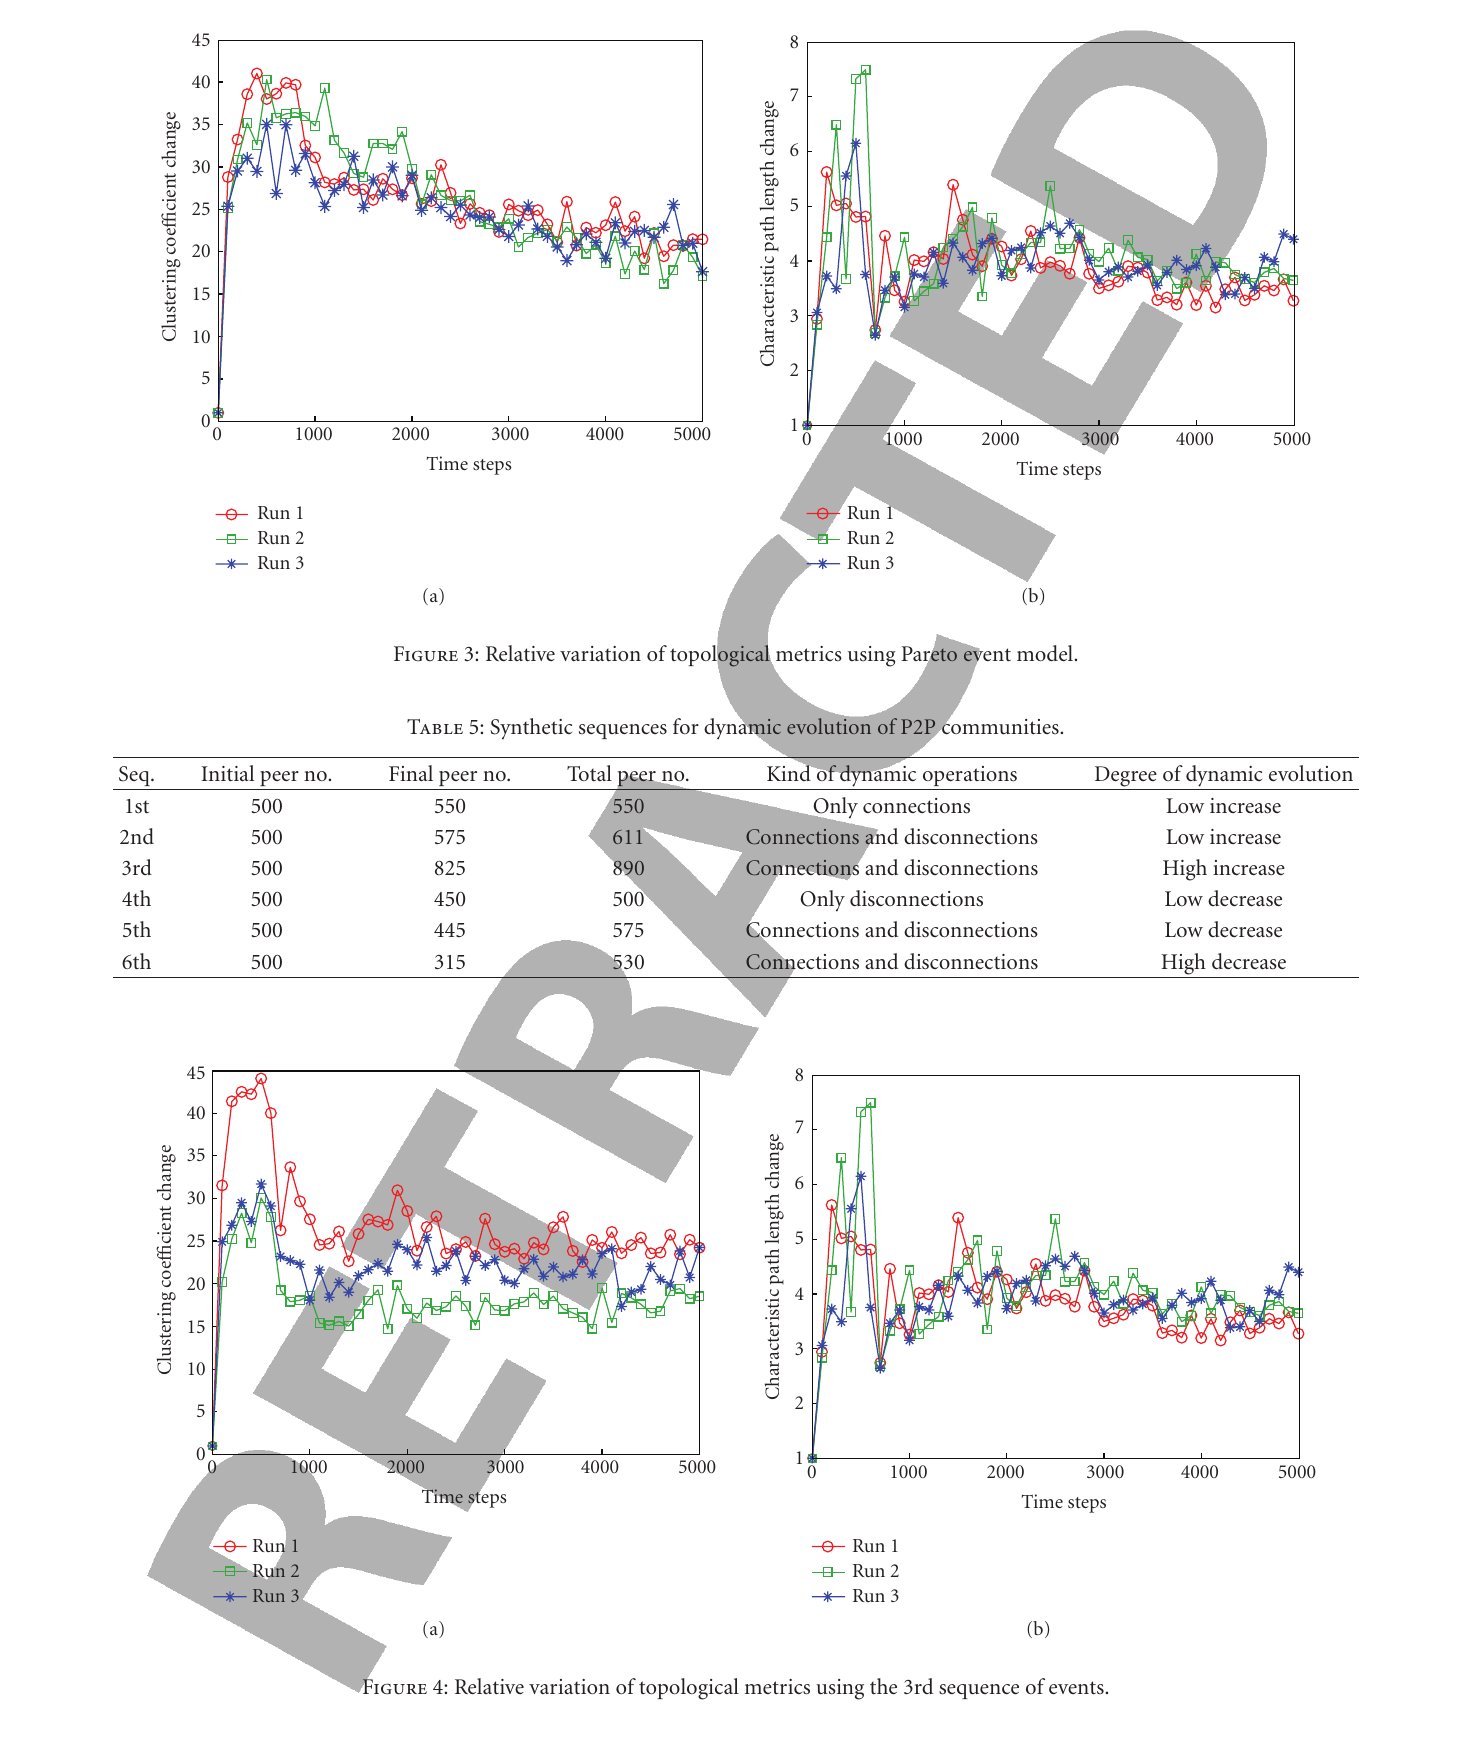
Figure 3: Relative variation of topological metrics using Pareto event model. Table 5: Synthetic sequences for dynamic evolution of P2P communities.